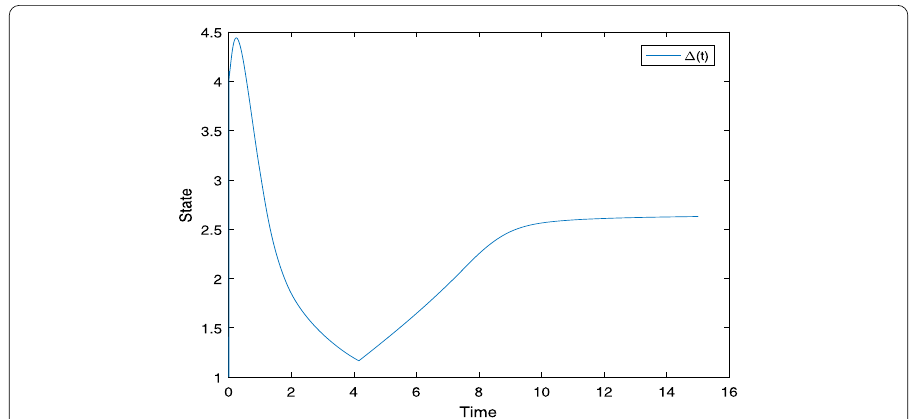
Figure 3 Variation of (cid:15) ( t ) in Example 4.1 of (4.1) without control